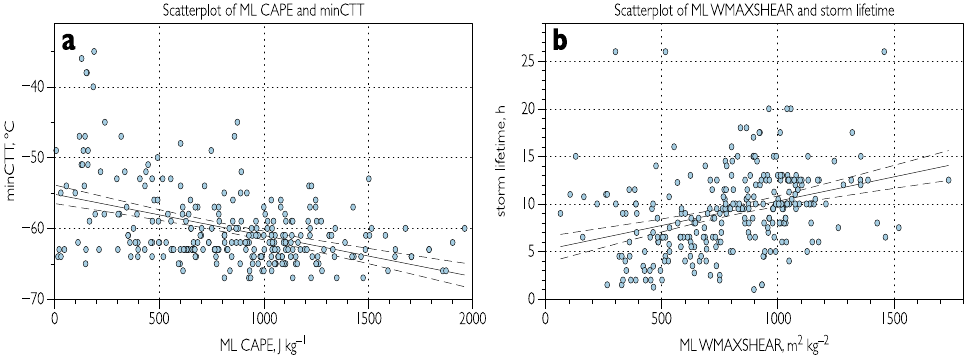
Figure 9. ( a ) Relationships between ( a ) ML CAPE and minCTT, and ( b )—ML WMAXSHEAR and lifetime of convective storms.